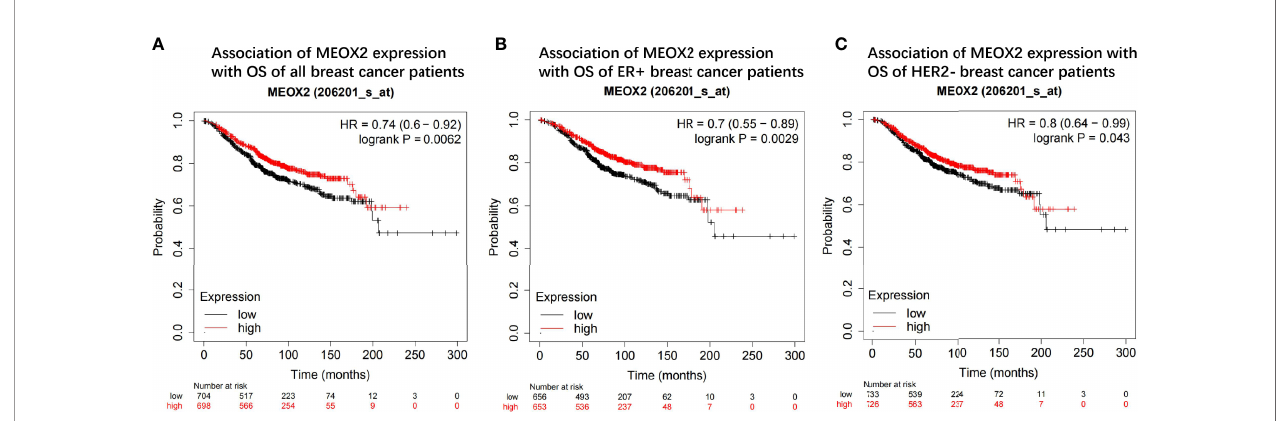
FIGURE 6 | Prognosticvalue of the MEOX2 gene in breast cancer tissue in KMplotter (A) OS of allbreast cancer patients; (B) OS ofER+ group; (C) OS of HER2-